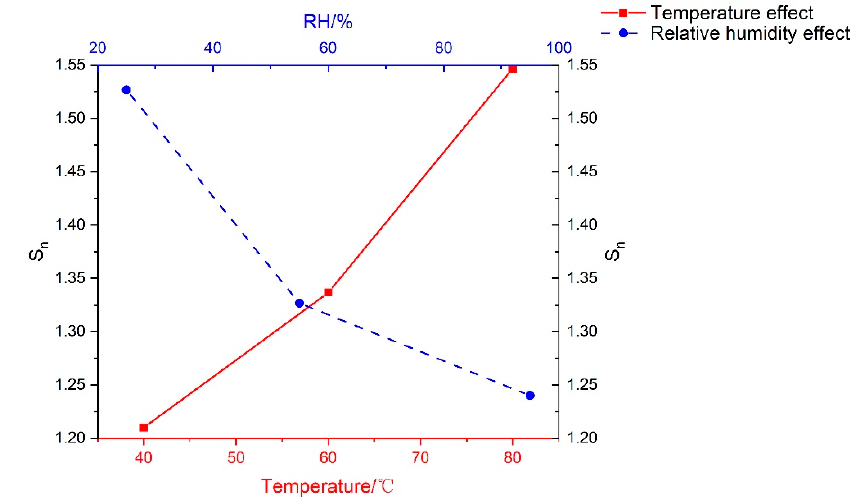
Figure 12. Relationship curves of average relative peak strain of testing specimens.